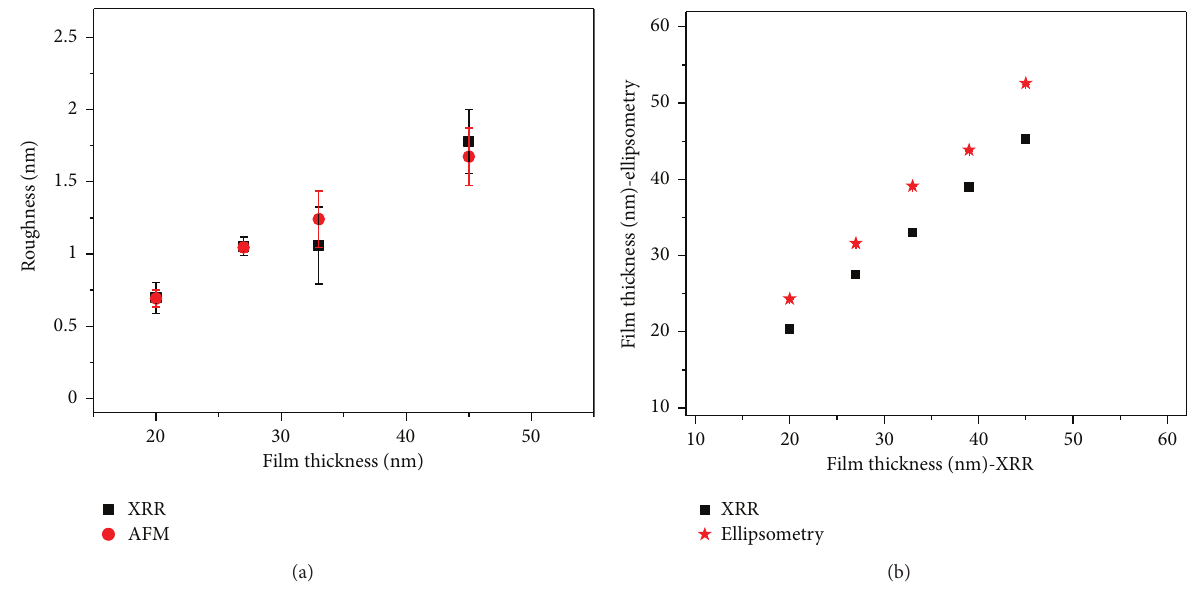
Figure 5: Comparing the measured and calculated (a) roughness from AFM and XRR data and (b) thickness from ellipsometry and XRR data. As can be seen in these figures, results from different methods match.